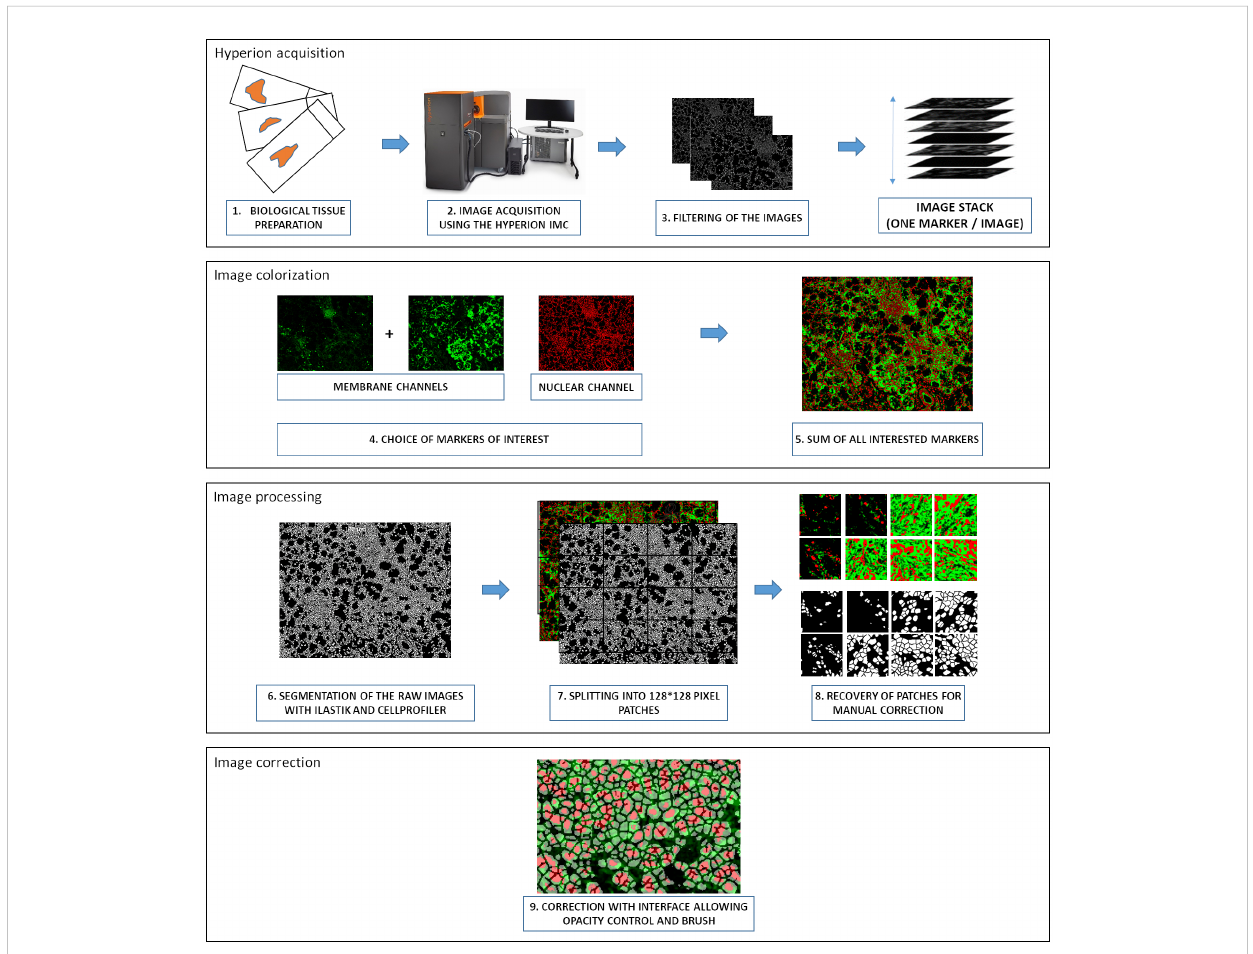
FIGURE 1 Graphical overview of the pre-processing steps to build the IMC training dataset. The pre-processing steps required to train the neural network of the YOUPI software consist of the following: 1. The preparation of biological tissues, 2. The acquisition of images with the HYPERION IMC, 3. The fi ltering of the images, 4. The selection of interesting markers, 5. The summation of interested markers, 6. The segmentation of raw images with Ilastik and CellPro fi ler, 7. The splitting of segmented images in 128×128 pixel patches, 8. The recovery of patches for manual correction, 9. The correction with the interface, allowing for opacity control and brush. IMC: Imaging Mass